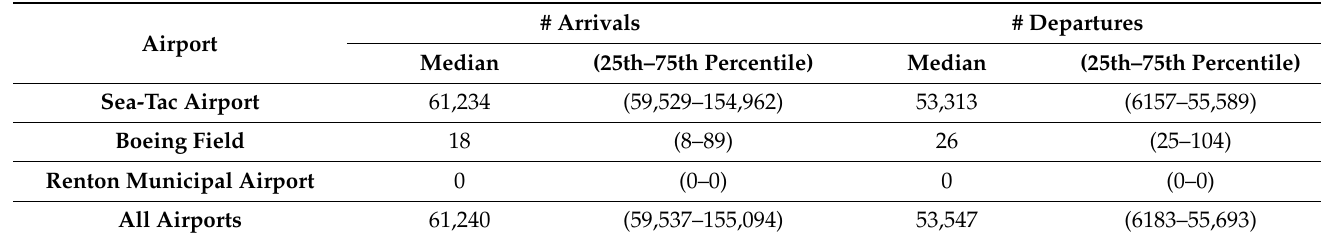
Table 8. Number of arrivals and departures below 750 m and within a one-mile radius of study schools in 2019. Flight information including the median and 25th–75th percentiles are provided for the three airports in the